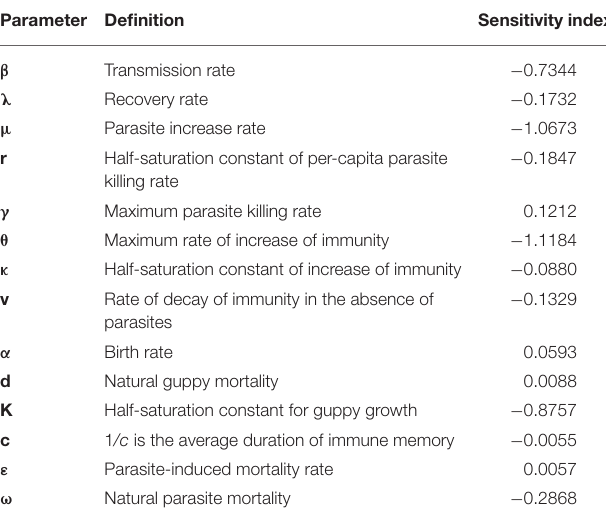
TABLE 4 | The sensitivity of the magnitude of the peak of a generic outbreak to the